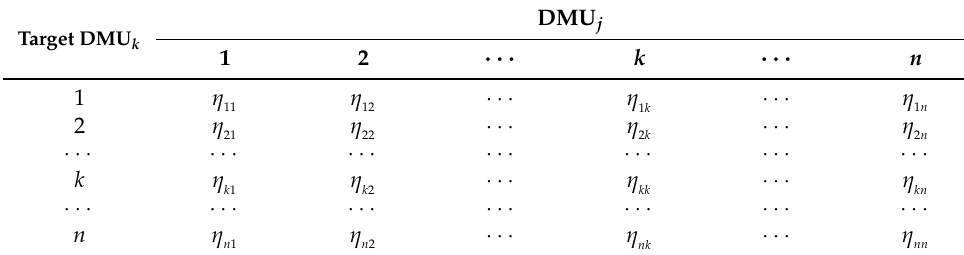
Table 1. Cross-efficiency matrix for n